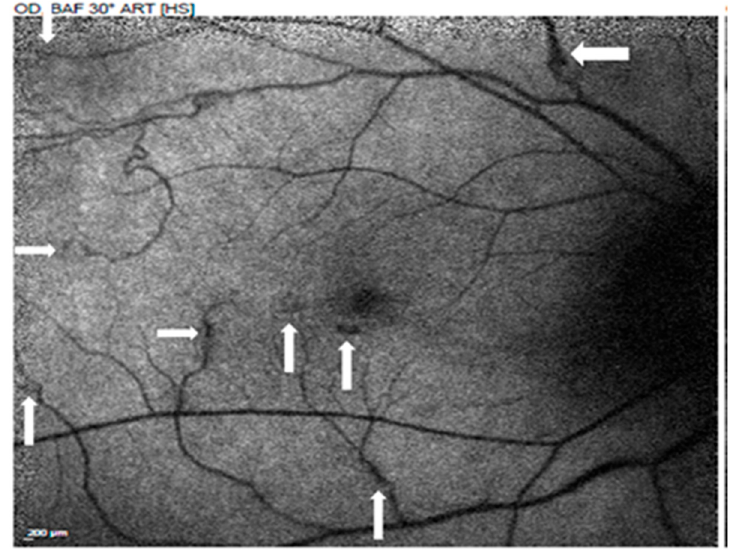
Figure 2. Traditional fluorescein angiography showed aneurysmal dilation ( A , 40 s after the fluorescein injection, arrow) of peripapillary and optic disc retinal arterioles, peripheral capillary nonperfusion ( B , 1 min after the fluorescein injection, arrow), focal inflammation of the optic nerve ( C , 4 min after fluorescein injection, black arrow), peripapillary retina ( C , white arrow), macula ( C , gray arrow), and retinal vasculitis in the right eye.